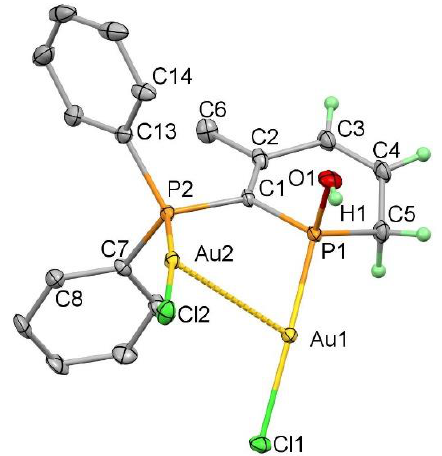
Figure 3. Molecular structure of 25 (thermal ellipsoids at 50%; H atoms on the Ph and Me groups have been omitted for clarity). A chloroform solvate molecule has also been omitted for clarity. Selected bond lengths (Å) and angles ( ◦ ): Au1-Au2 3.0576(2), Au1-Cl1 2.3047(9), Au1-P1 2.2180(10), Au2-Cl2 2.2919(10), Au2-P2 2.2401(10), P1-O1 1.596(3), P1-C1-1.787(4), P1-C5 1.800(4), P2-C1 1.818(3), C1-C2 1.370(5), C2-C3 1.462(5), C3-C4 1.340(6), C4-C5 1.490(6), P1-Au1-Cl1 169.29(4), P2-